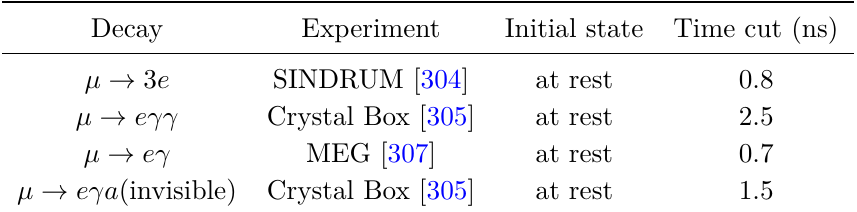
Table 10 . Cuts on the decay time of the ALP that should be applied in various LFV experiments.